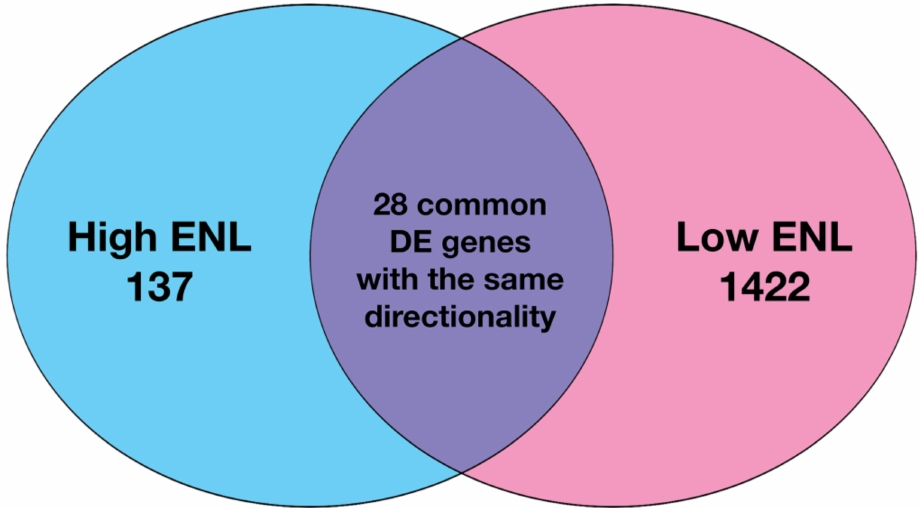
Figure 1. Venn diagram of differentially expressed genes following flaxseed lignan extract supple- mentation in participants exhibiting high and low ENL